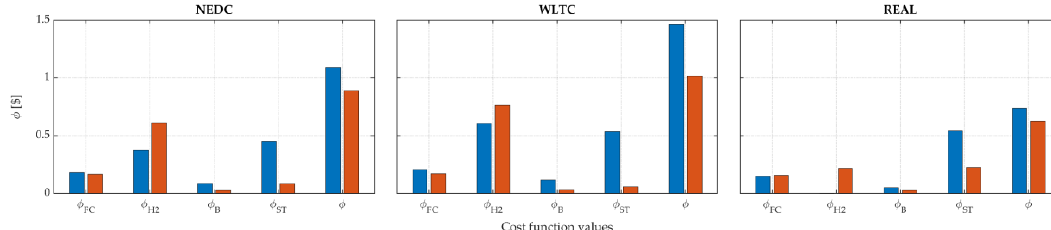
Figure 20. Voltages, state-of-charge and costs achieved over REAL by H-EMS ( on the left ) and S-EMS ( right ).